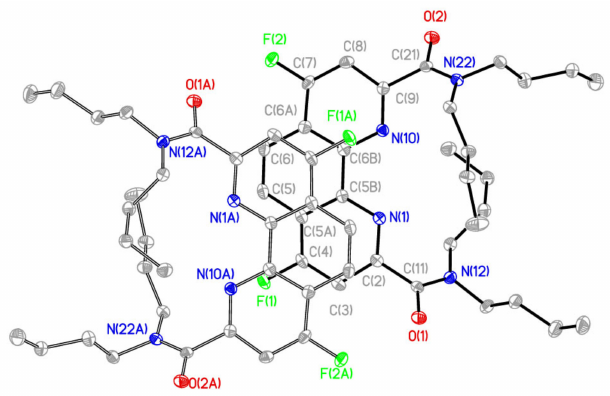
Figure 5. Centrosymmetric dimers in the crystal of 7a